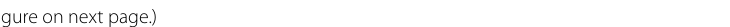
figure on next Fig. 3 Variations in patterns of association between fasting glycemia ( A ), post‑load (2 h) glycemia ( B ) and maternal BMI ( C ) with the amount of placental 13 C‑DHA lipids (Z‑score, log2; n 17 placenta). Linear regression was run with lipid as the outcome and glycemia or BMI as the = predictor. The Benjamini–Hochberg method was used to correct for multiple testing. Solid lines show statistically significant associations, while dashed lines show non‑significant trends. Shaded areas show 95% confidence intervals. Key for dots in A and B —Red: Normal BMI (< 23 kg/m 2 ), Green: Overweight (BMI 23.0 to < 27.5 kg/m 2 ), Blue: Obese (BMI 27.5 kg/m 2 ). Key for dots in C —Purple: non‑GDM, Black: GDM. BH Benjamini– ≥ Hochberg, CI confidence interval, DG diacylglycerol, DHA docosahexaenoic acid, GDM gestational diabetes, LPC lyso‑phosphatidylcholine, LPE lyso‑phosphatidylethanolamine, PC phosphatidylcholine, PE-P phosphatidylethanolamine‑plasmalogen, TG